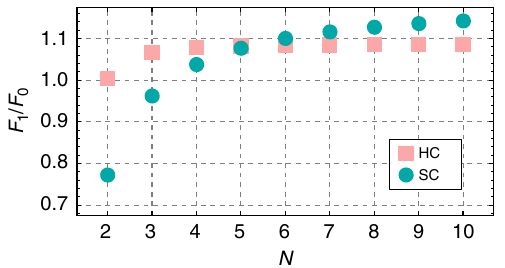
Figure 2 | Magnetic dipole forces. Reduced total magnetic dipole–dipole force acting on particle 1, F 1 / F 0 , in a chain cluster as a function of the number of dipoles N . The squares represents the analytical results for hard sphere dipoles. The circles represents the numerical results for soft-spheres using the WCA-potential, as shown in Fig. 1c. Note that the scale F 0 depends on the potential, see text